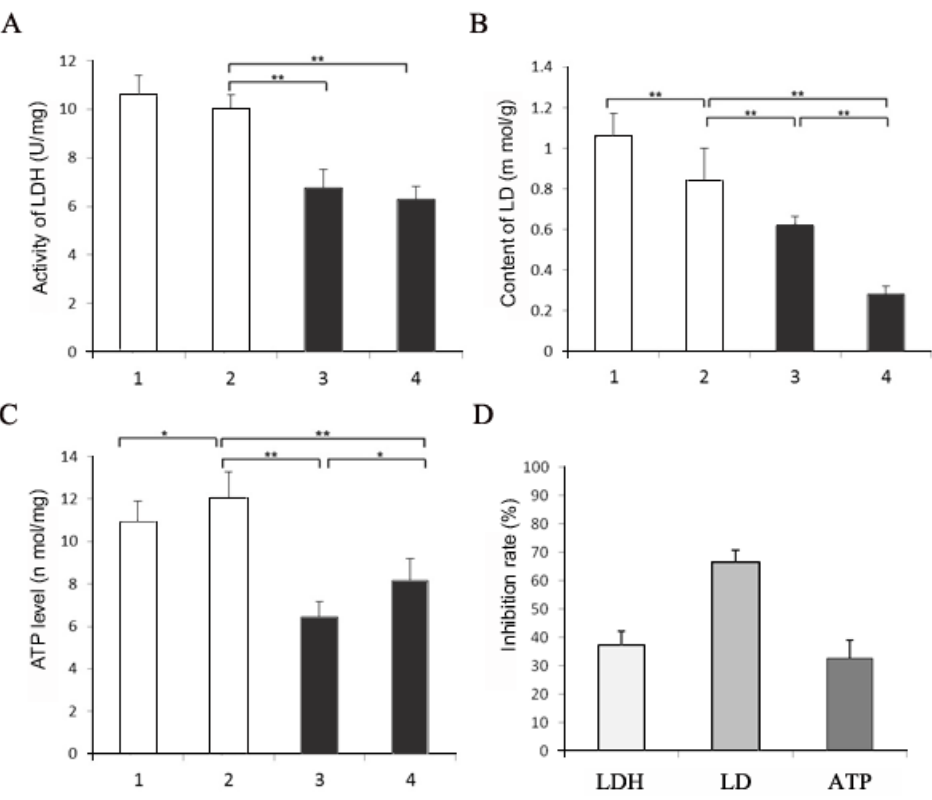
Figure 7. Comparison of LD, LDH, ATP and their inhibition rate of plateau pika skeletal muscle with different treatments. ( A ) LDH activity in the skeletal muscle of plateau pika. ( B ) LD content in the skeletal muscle of plateau pika. ( C ) ATP level in the skeletal muscle of plateau pika. ( D ) Inhibition rates of LDH, LD and ATP in the skeletal muscle. Group 1: taking samples when swimming till exhausted with each bilateral biceps femoris of hind legs injected 0.5 mL normal saline; Group 2: taking samples with each bilateral biceps femoris of hind legs injected 0.5 mL normal saline; Group 3: taking samples when swimming till exhausted with each bilateral biceps femoris of hind legs injected 0.5 mL 1mol/L isopropyl oxamate; Group 4: taking samples with each bilateral biceps femoris of hind legs injected 0.5 mL 1 mol/L isopropyl oxamate. All animals were forced to rest for 30 min after injection. Water temperature: 9–10 °C. All data were expressed as mean ± SD; sample size was 10 for each group. The activity of LDH in Group 1–4 were 10.59 ± 0.79 U/mg, 10.01 ± 0.59 U/mg, 6.74 ± 0.77 U/mg and 6.30 ± 0.50 U/mg, respectively; the LD content in Group 1–4 were 1.06 ± 0.11 mmol/g, 0.84 ± 0.16 mmol/g, 0.62 ± 0.043 mmol/g and 0.28 ± 0.039 mmol/g, respectively; the ATP level in Group 1–4 were 10.96 ± 0.94 nmol/mg, 12.06 ± 1.23 nmol/mg, 6.43 ± 0.75 nmol/mg and 8.15 ± 1.03 nmol/mg, respectively; the inhibition rates of LDH, LD and ATP in the skeletal muscle were 37.12%, 66.27%, and 32.42%, respectively. * p < 0.05, ** p <